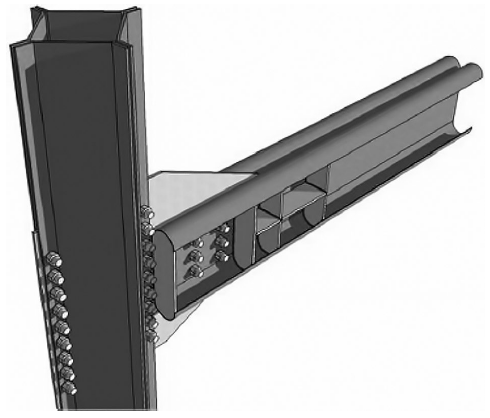
Fig. 4. Beam to column connection with stiffeners (Sabbagh et al. 2013)